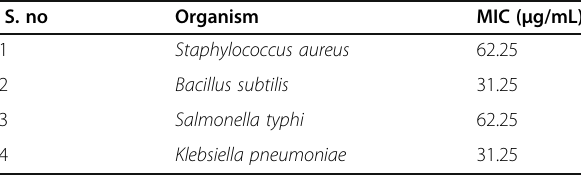
Table 4 Minimal inhibitory concentration of root extract of